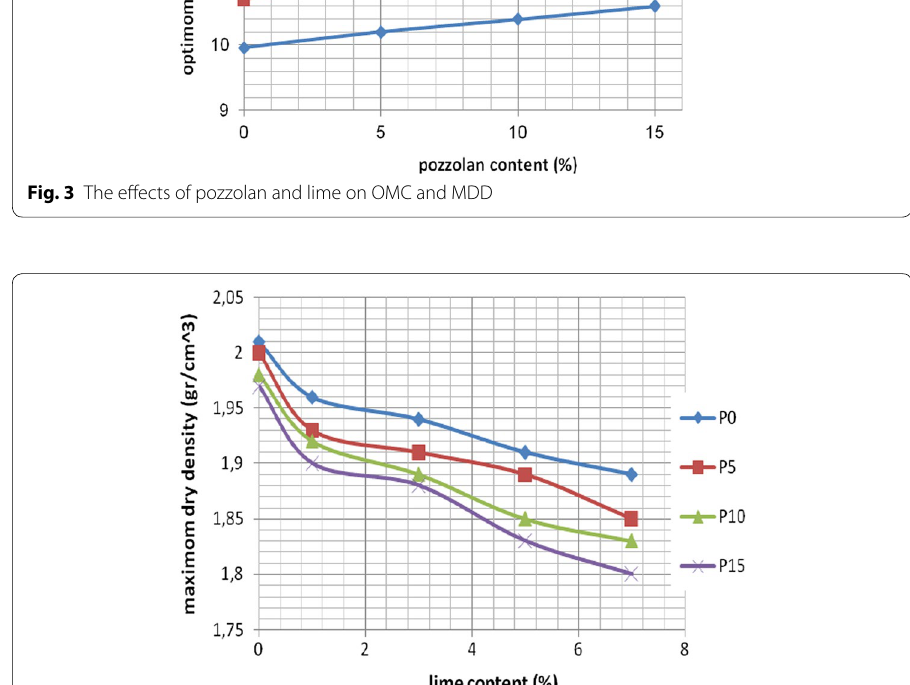
Fig. 4 The effects of lime on